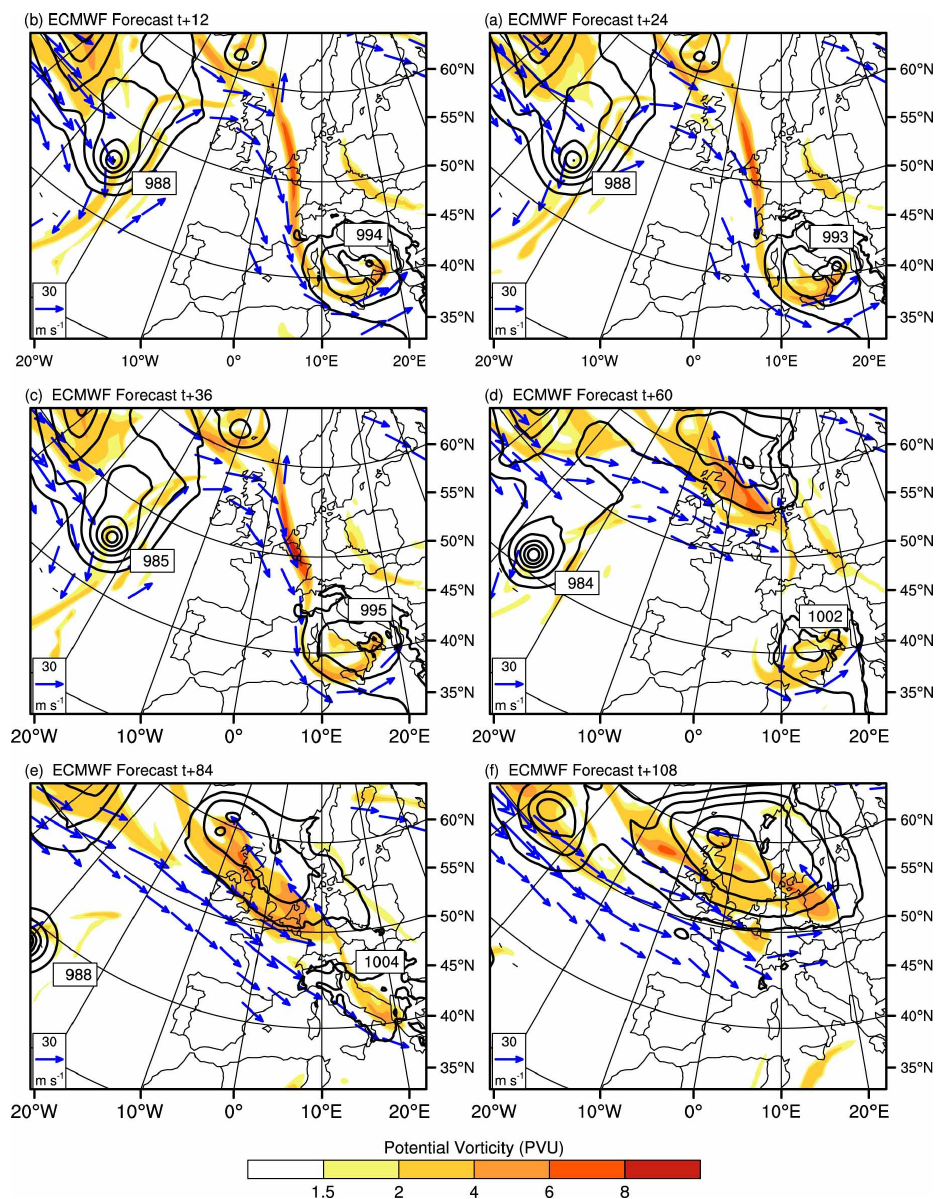
Figure 6. ECMWF forecasts at 12:00UTC on 26 September 2006: PV at 300hPa (shaded, PVU = 10 − 6 Km − 2 s − 1 kg − 1 ), wind at 300hPa (vectors, for winds greater than 30ms − 1 ) and mean sea-level pressure (solid lines, every 4hPa between 976 and 1008hPa). Forecasts are at (a) t + 12, (b) t + 24, (c) t + 36, (d) t + 60, (e) t + 84 and (f) t + 108. The figures (when applicable) indicate the local mean SLP minima over the North Atlantic Ocean and the Mediterranean Sea associated with Hurricane Helene and the medicane, respectively. Reprinted from Chaboureau et al. (2012) with